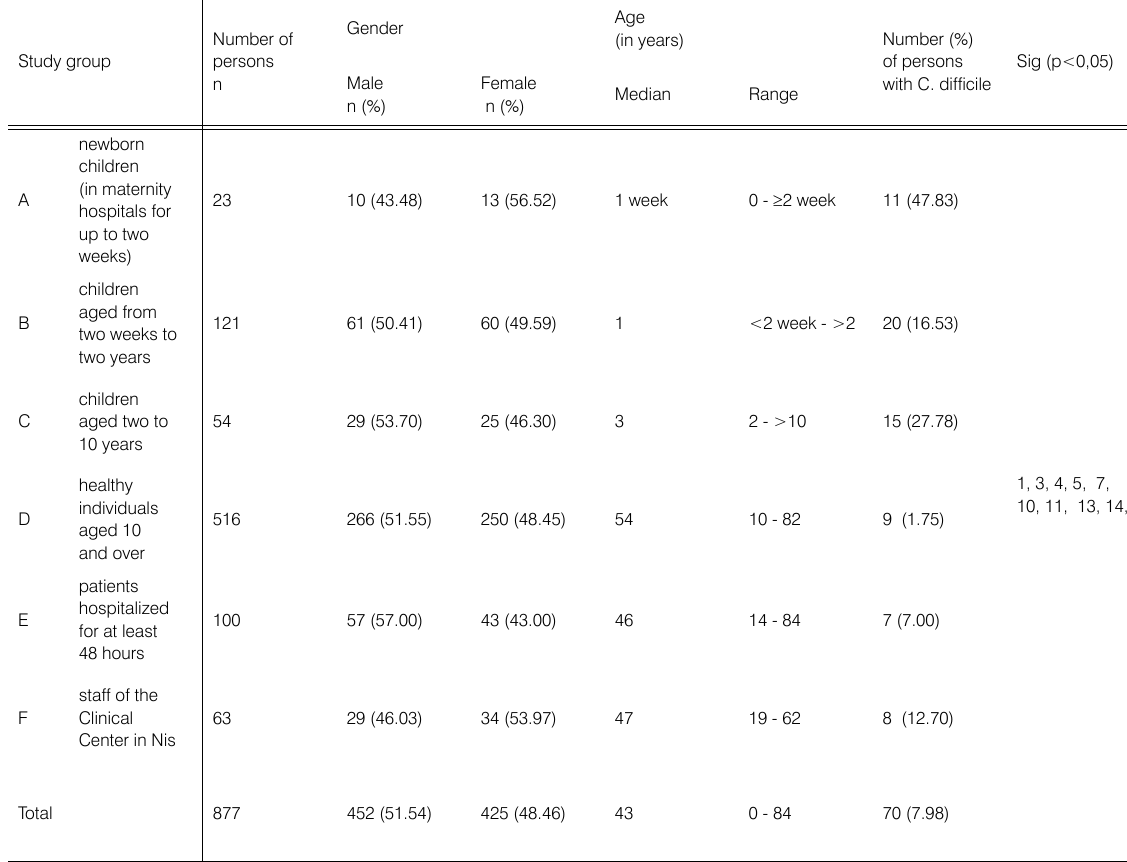
Table 1. Basic demographic data and intestinal carriership of Clostridium difficile in persons in six study